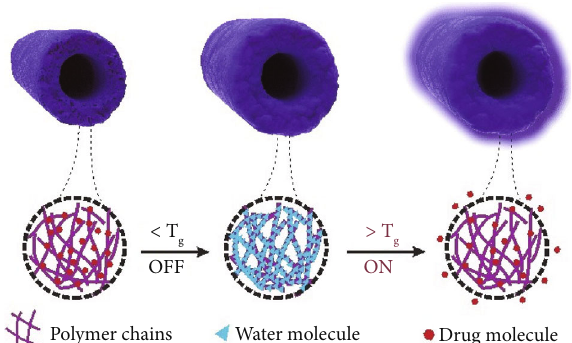
Figure 6: Schematic of changes in the thermo-responsive fi